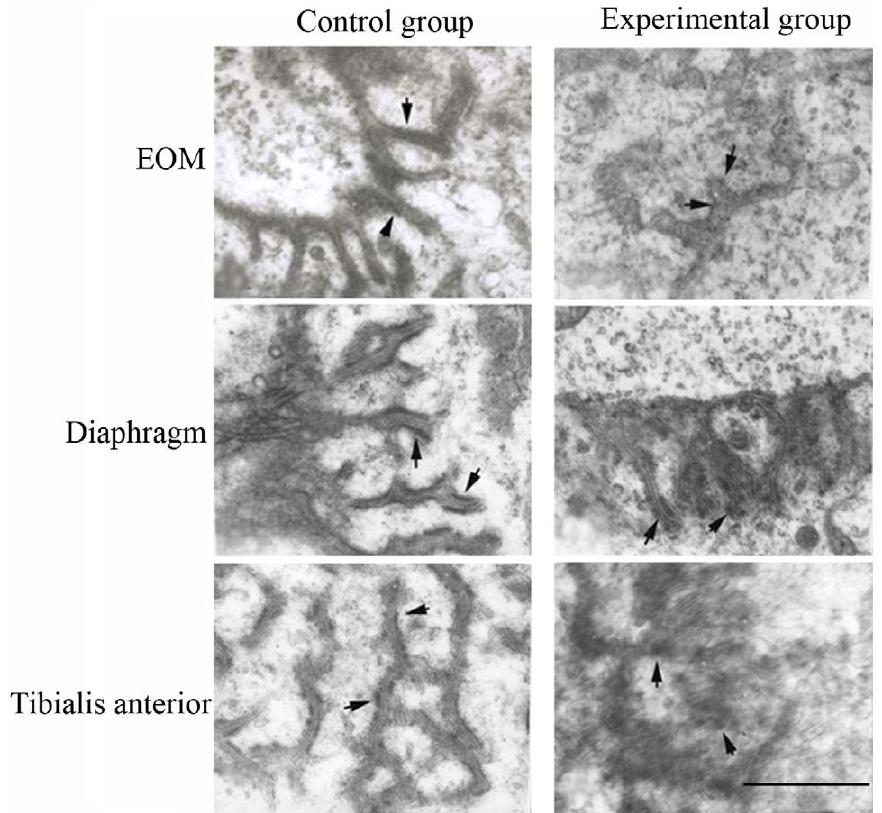
Figure 6. Ultrastructure of acetylcholine receptors labeled with a -bungarotoxin in the neuromuscular junction of three muscles in the two groups. Scale bar=2 m